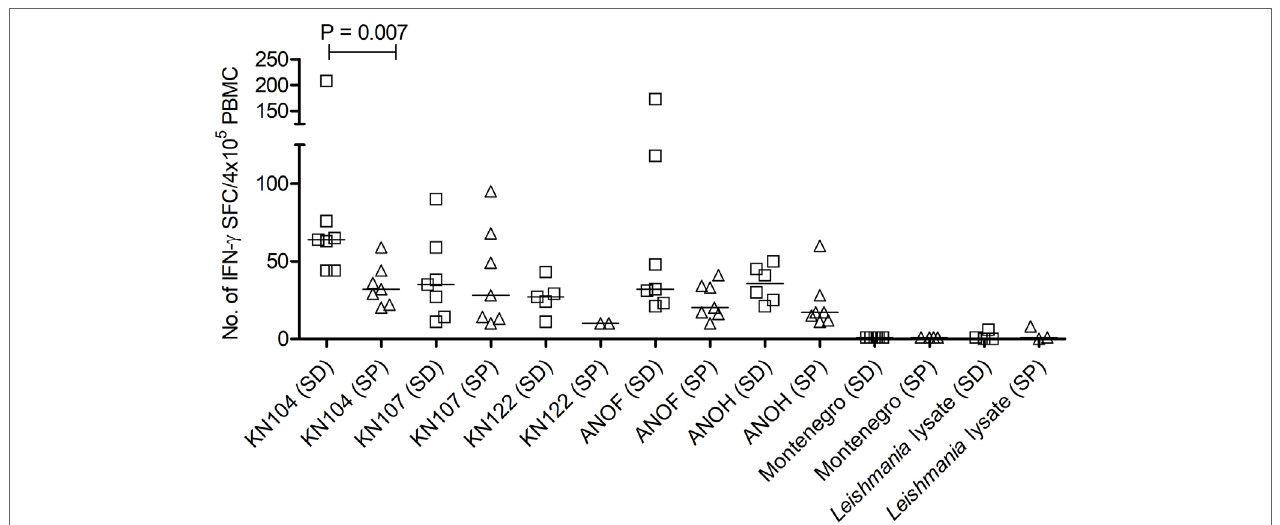
FigUre 2 | Number of interferon (IFN)- γ –secreting cells in response to Trypanosoma cruzi -derived recombinant proteins in serodiscordant and seropositive subjects for T. cruzi infection. Peripheral blood mononuclear cell (PBMC) were seeded at 4 × 10 5 cells/well and stimulated with T. cruzi -derived recombinant proteins and Montenegro Leishmania antigen or media alone, for 16–20 h. Each symbol represents the mean spot number of triplicate wells for each serodiscordant (squares) or seropositive (triangles) with positive IFN- γ enzyme-linked immunosorbent spot (ELISPOT) responses to the indicated T. cruzi -derived recombinant protein, as defined in material and methods. Spot counts with media alone were subtracted. Horizontal lines depicting median values are shown. Responses to Montenegro Leishmania antigen or in house Leishmania lysate were measured as negative controls. Significant differences between subject groups were determined by Mann–Whitney U test.